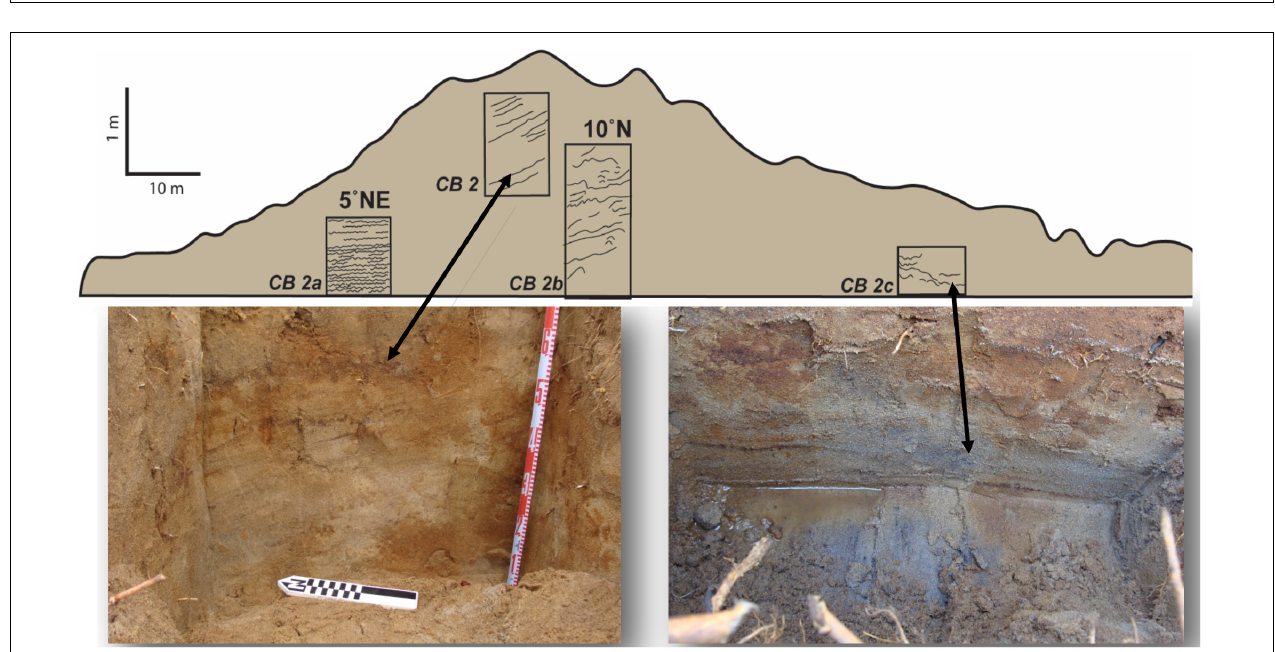
FIGURE 4 | Stratigraphic sections showing facies, sedimentary structures, and OSL age estimates. Section locations illustrated in Figure 3 .